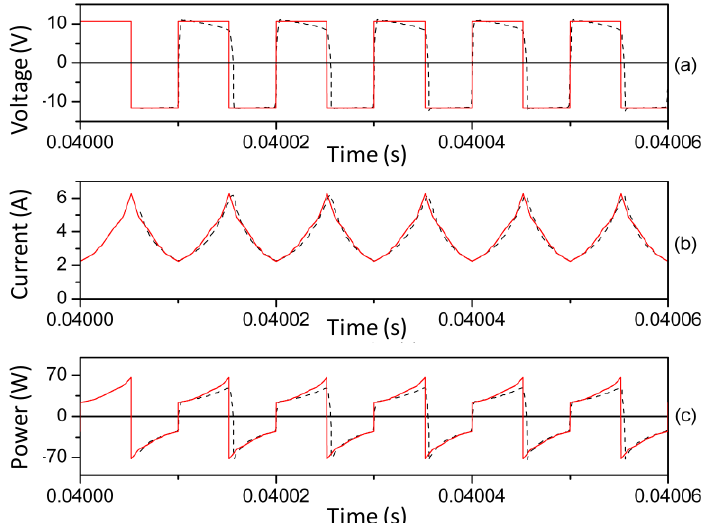
Figure 11. Experimental (-  -  -) and simulated (  ) waveforms at 100 kHz. V and time step  = 10 −8 s.